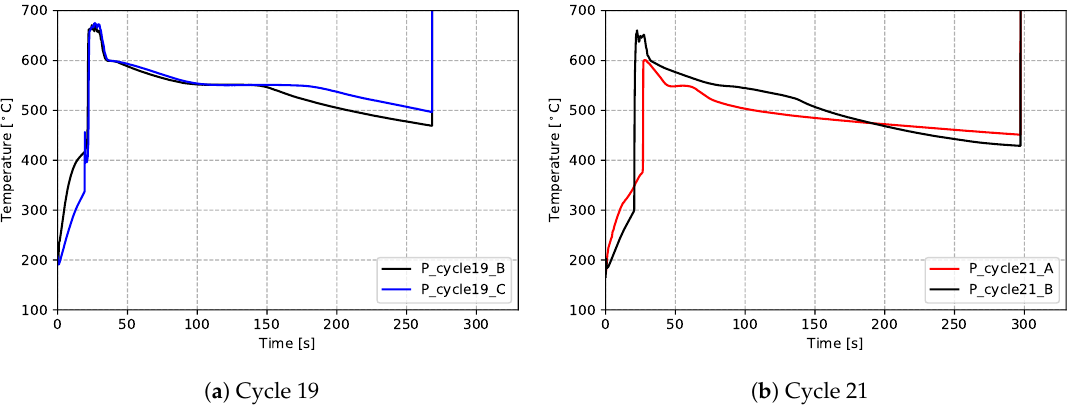
Figure 10. Temperatures measured from cast-in TCs (in wheel)—production process condition.